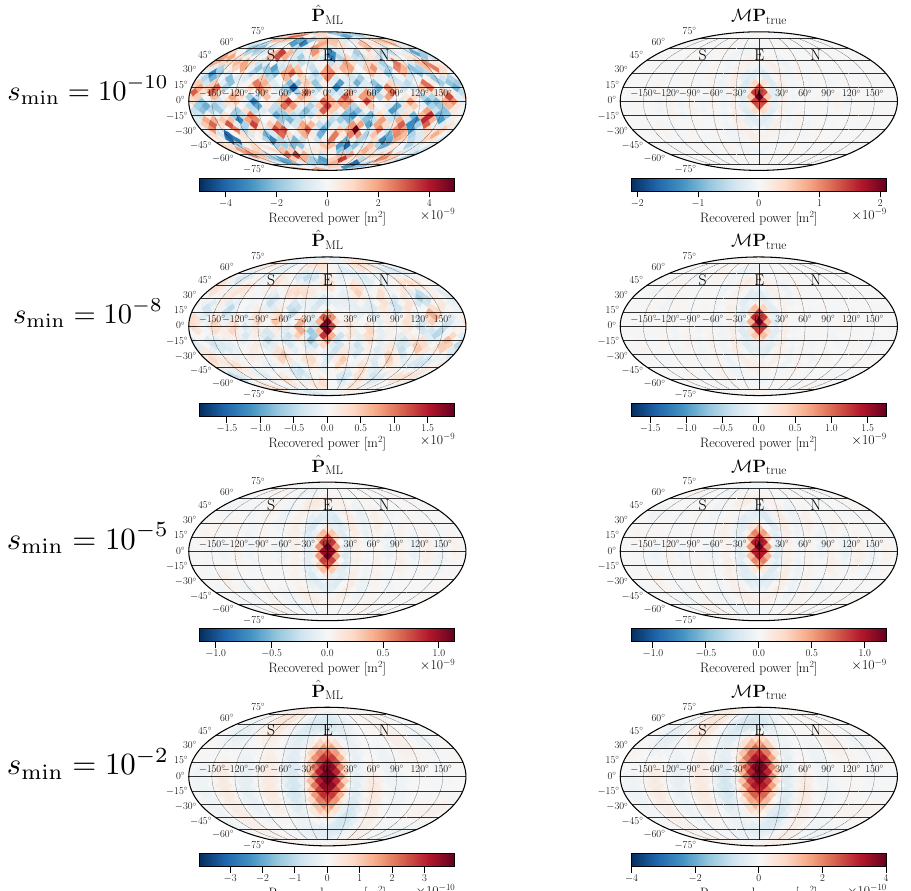
Figure 2. Left column shows the maximum likelihood recovery for a simulated P-wave injection, ˆ P ML . Right column shows the model resolution matrix of the P-wave overlap reduction function, P true . Each row represents a different choice of s min . We see that as the spot size plotted as a map, M in the model resolution plots increases, the covariance in each pixel decreases. In these maps, 0 ◦ in the azimuthal coordinate corresponds to eastward propagation, while 90 ◦ corresponds to northward